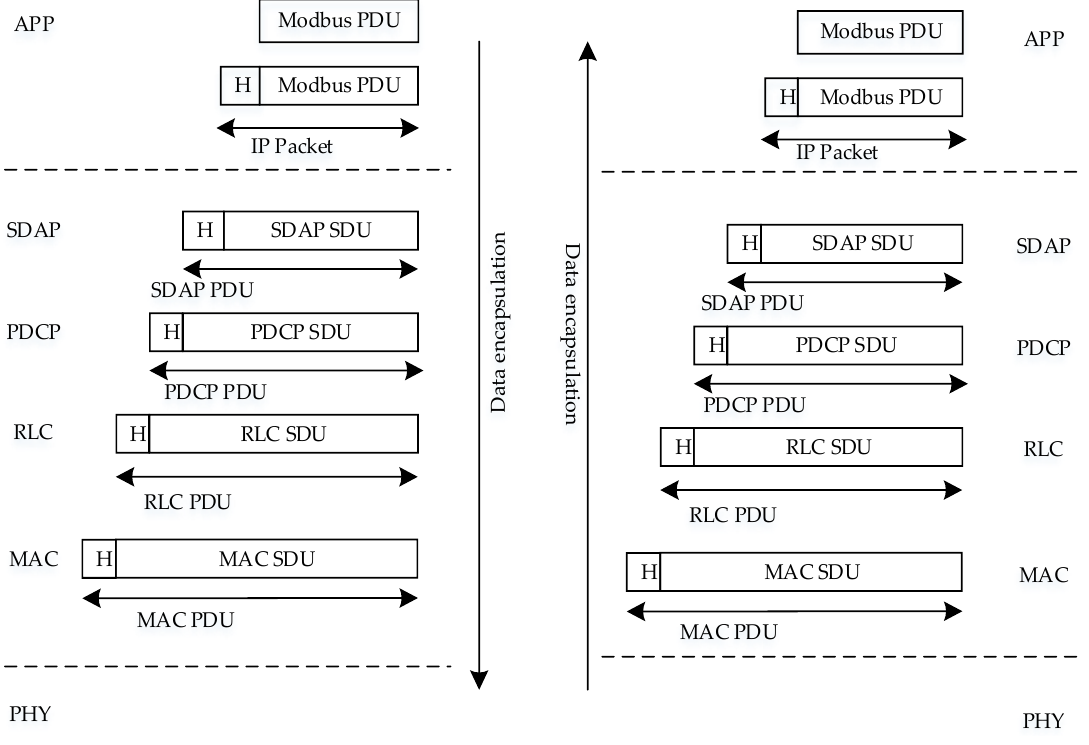
Figure 7. The encapsulation and decapsulation process of 5G data.